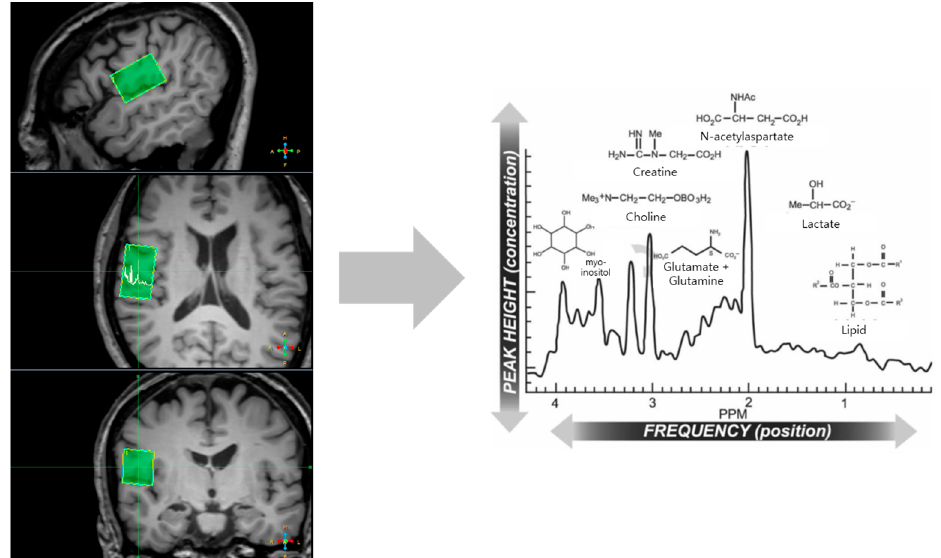
Figure 3. Region of interest for magnetic resonance spectroscopy (MRS). After each metabolite is classified according to ppm through MRS, using the region of interest used to check the GMV and WMV, the concentration was confirmed through the peak height. Abbreviations: PPM, parts per million.